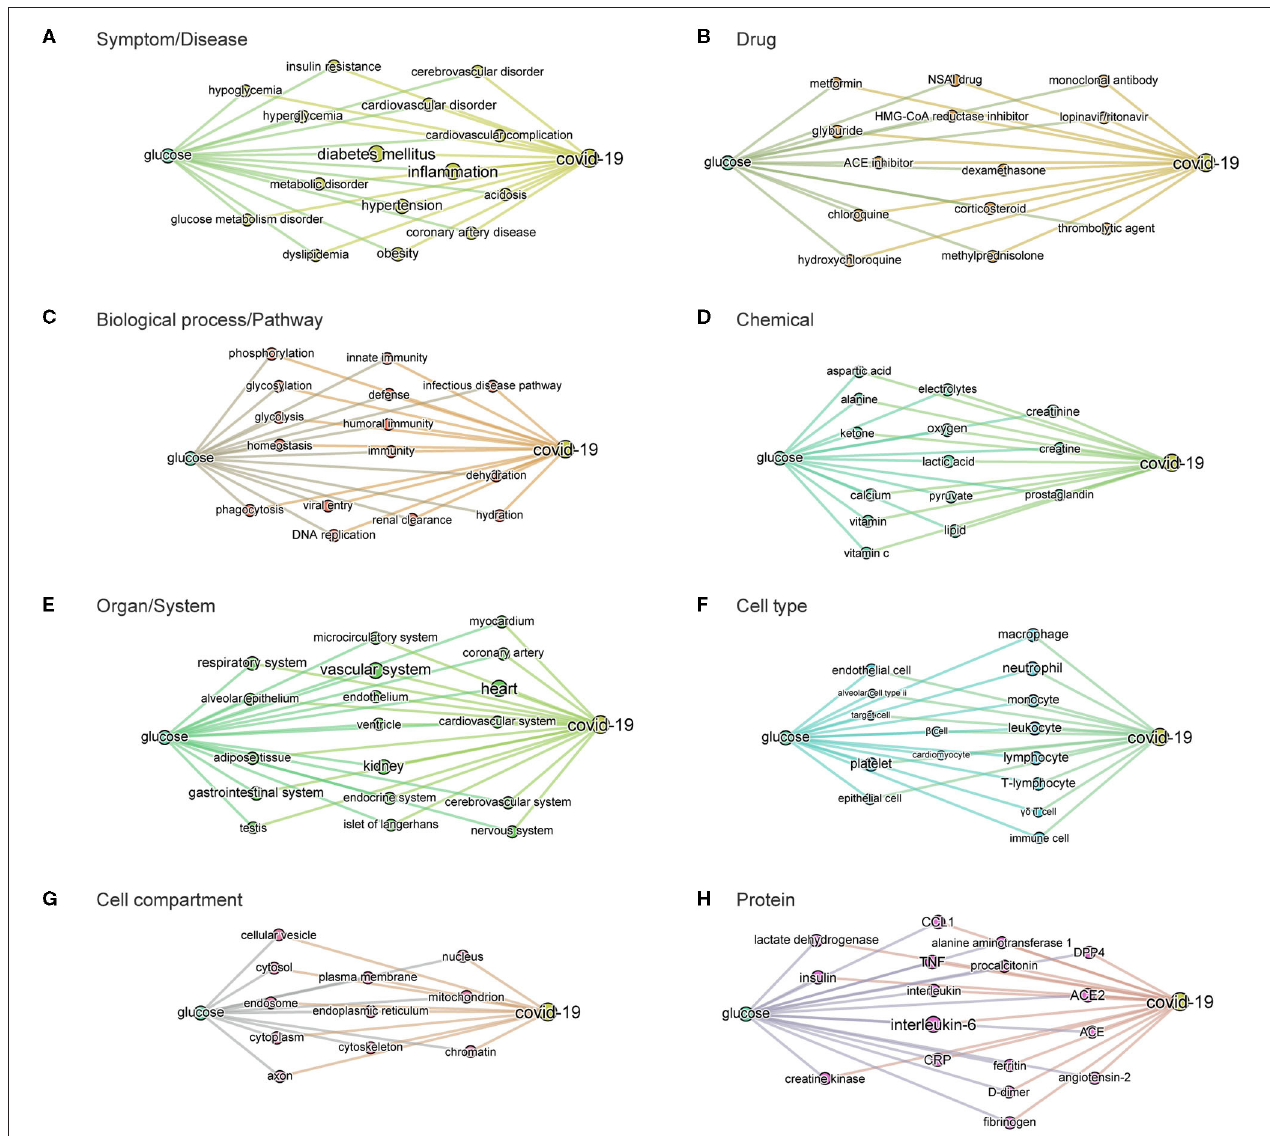
FIGURE 6 | BMIPs subgraphs from glucose to COVID-19 in each entity type. To obtain the subgraphs we, first, sliced the knowledge graph (built from the 3,000 most relevant articles related to the query “glucose as a risk factor for COVID-19”) according to different entity types (see Figure 2 ). As a result, we obtained a subgraph per entity type, containing only the entities of the given type. We then added the terms “glucose” and “COVID-19” to each of the subgraphs and then computed BMIPs from “glucose” to “COVID-19.” (A) Symptom/disease. (B) Drug. (C) Biological process/pathway. (D) Chemical. (E) Organ/system. (F) Cell type. (G) Cell compartment. (H)